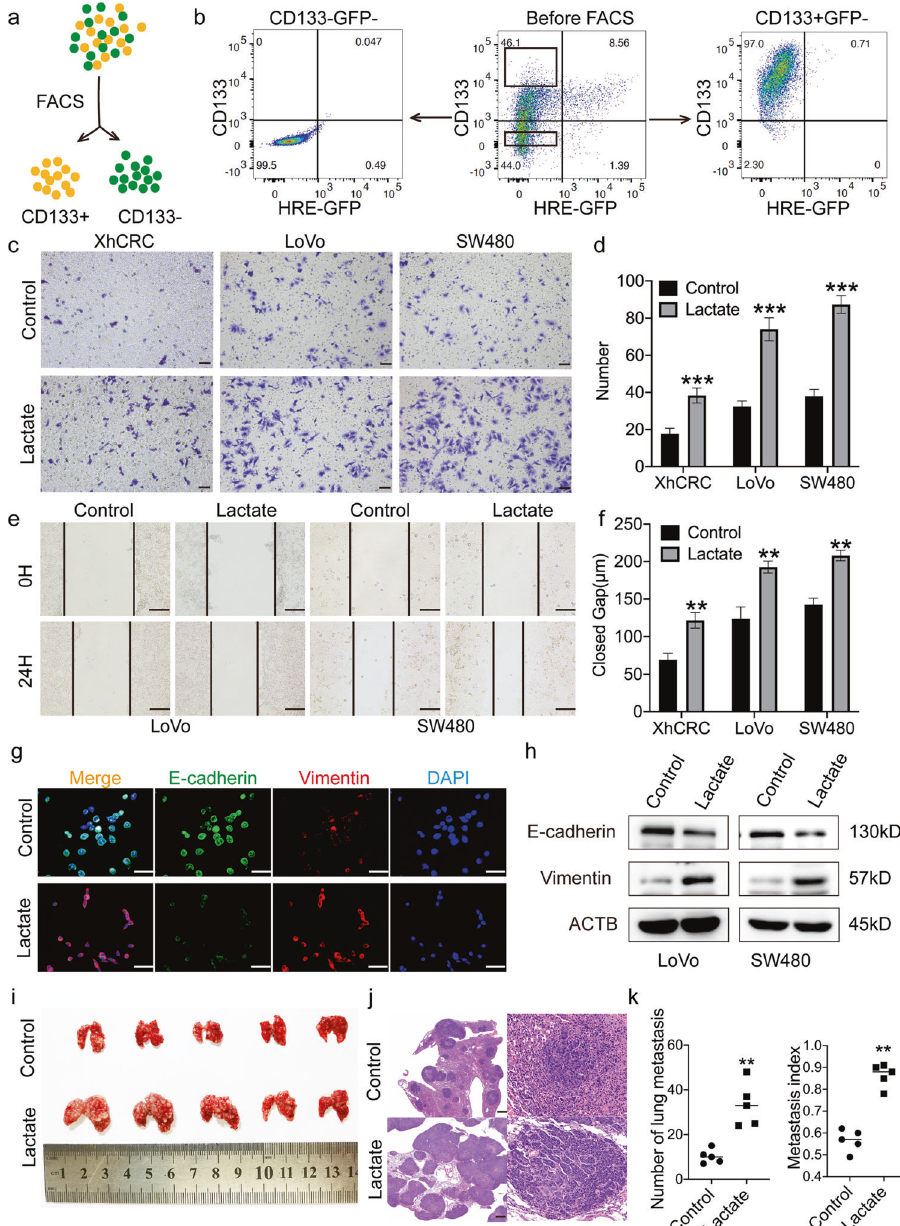
Fig. 2 Lactate enhances metastatic potential of normoxic CSCs. a Schematic of CD133 + GFP − and CD133 − GFP − cell sorting. b An example of post-sorting analysis of puri fi ed CD133 + GFP − and CD133 − GFP − LoVo cells. Transwell invasion assays. XhCRC, LoVo and SW480 normoxic sphere-forming cells were proceeded into single cells and incubated with DMEM containing 5 mM lactate or control medium in 37 °C, 24 h later, invaded cells were photographed ( c ) and quanti fi ed ( d ). Scale bar: 200 μ m. e , f Wound healing assays. XhCRC, LoVo and SW480 normoxic sphere-forming cells were cultured in the presence of 5 mM lactate for 24 h, DMEM/F12 as control. Representative images were shown in e . Quanti fi ed analysis was shown in f . Scale bar: 50 μ m. g Representative immuno fl uorescence staining images of E-cadherin (green) and Vimentin (red) in LoVo normoxic sphere-forming cells treated with DMEM/F12 medium containing 5 mM lactate, DMEM/F12 medium as control. Nuclei were stained in blue. Scale bar: 50 μ m. h Immunoblot analysis of E-cadherin and Vimentin in LoVo and SW480 normoxic sphere-forming cells treated with DMEM/F12 medium containing 5 mM lactate, DMEM/F12 medium as control. Loading control was assessed by ACTB (i.e. β -actin). i – k 1 × 10 6 CD133 + GFP − SW480 cells treated with DMEM/F12 medium containing 5 mM lactate or DMEM/F12 medium as control were injected into tail vein of NOD/SCID mice ( n = 5). Lactate treatment started 72 h pre injection. After 8 weeks, lung metastasis was determined. Representative images of lung metastasis were shown in i. H&E-stained lung sections were shown in j . Quanti fi ed analysis of metastatic lung nodules was shown in k . Scale bar: 500 μ m. Data are expressed as mean ± SD. All in vitro experiments were repeated three times independently. * P < 0.05, ** P < 0.01, *** P < 0.001. Lactate oxidation promotes the migration and invasion of (MCT1) that inhibits lactate uptake in cells [26], the promoting normoxic CSCs by maintaining OXPHOS activity effect of CM was attenuated (Fig. 3g, j), suggesting that the The recycling and oxidation of TME-derived lactate is facilitated by lactate of glycolytic cell-derived CM may enhance OXPHOS MCT1, a transporter for exogenous lactate uptake [26], and lactate activity in normoxic CSCs. Cell Death and Disease (2022)